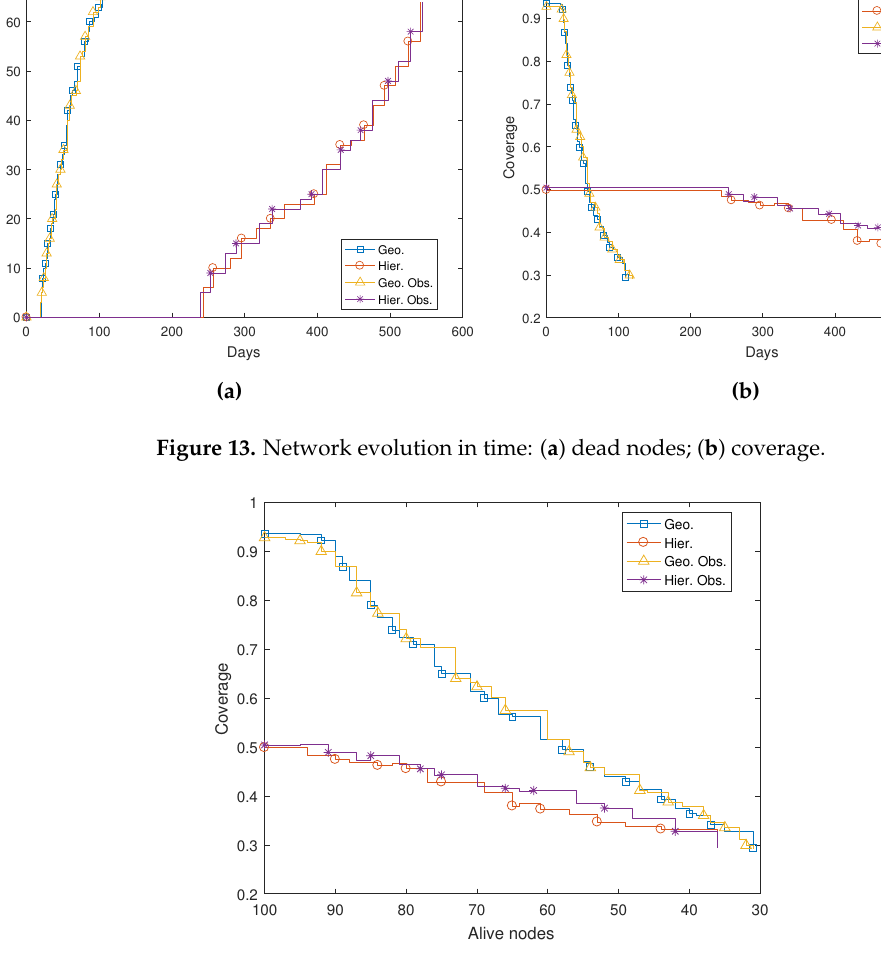
Figure 14. Coverage vs. number of nodes alive in an MWSN deployed with the proposed